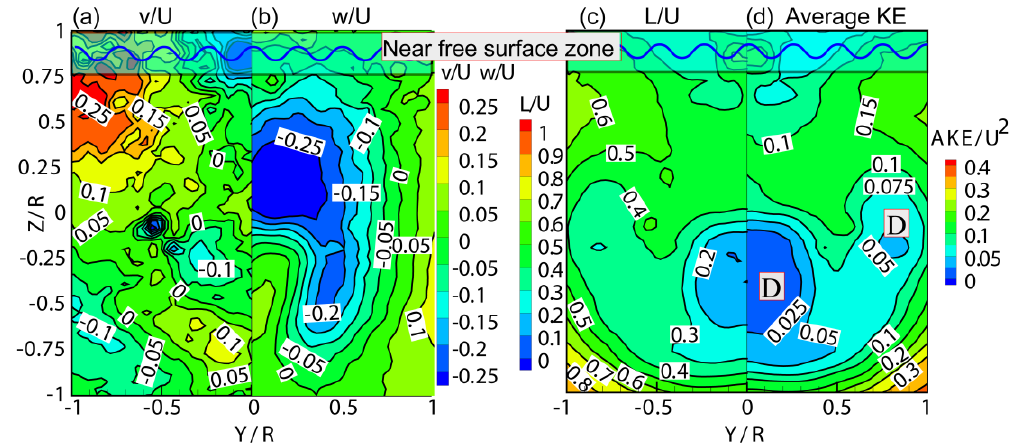
Figure 4. The dimensionless transverse velocity v/U , vertical velocity w/U , whole-flow velocity L/U , and average kinetic energy AKE/U 2 under the ballast conditions. ballast condition: ( a ) dimensionless transverse velocity v / U ; ( b ) dimensionless vertical velocity w / U ; ( c ) dimensionless whole-flow velocity L / U ; ( d ) dimensionless average kinetic energy AKE / U 2